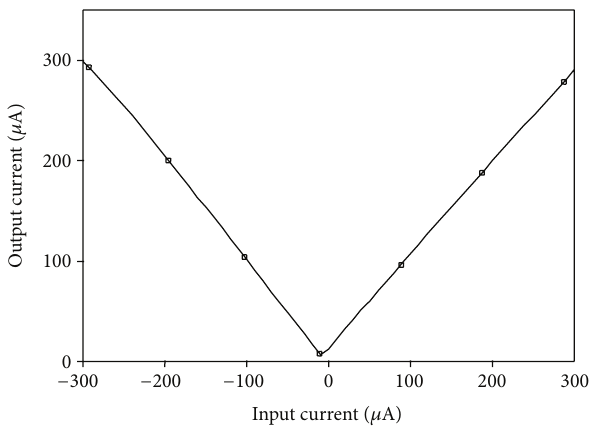
Figure 8: DC response of the proposed circuit.